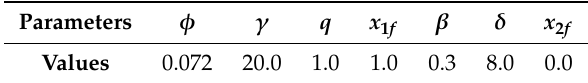
Table 1. Parameters of a continuous stirred tank reactor (CSTR).